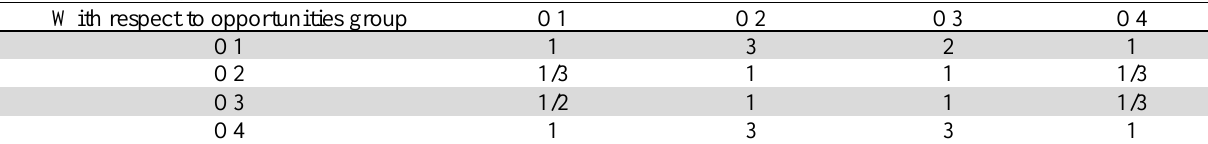
Priorities of opportunities CR = 0.8%) With respect to opportunities group